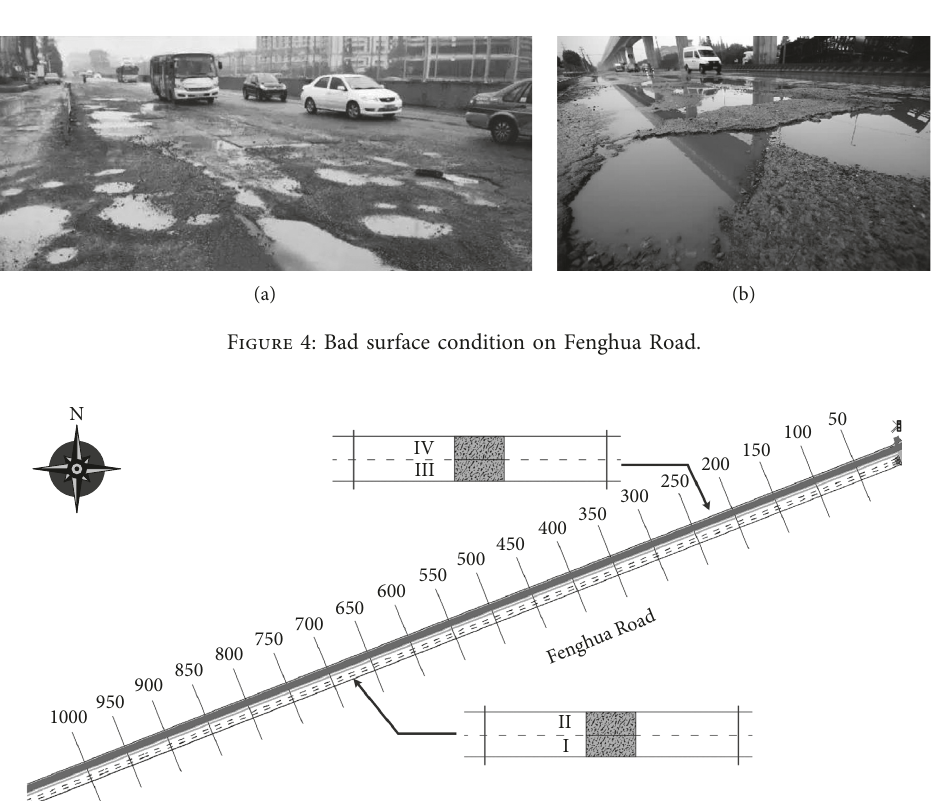
Figure 5: Distribution of potholes on Fenghua Road.